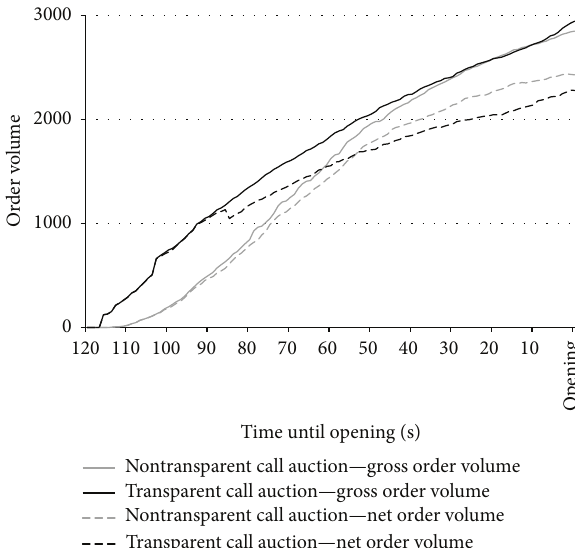
Figure 2: Gross and net average order volume during the preopen- ing phase. This figure displays the development of the average order volume in the transparent and nontransparent call auctions gross and net of cancellations over